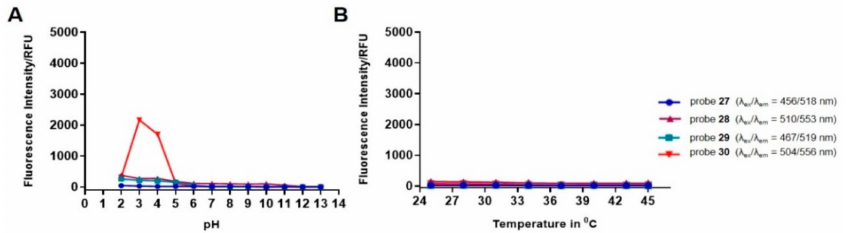
Figure 6. Stability of nitroreductase (NTR)-responsive fluorescent probes (1.0 µ M). ( A ) E ff ect of variation in pH from 2 to 13 at 25 ◦ C; ( B ) E ff ect of variation in temperature (25, 28, 31, 34, 37, 43, and 45 ◦ C) in PBS (10 mM, pH 7.4).